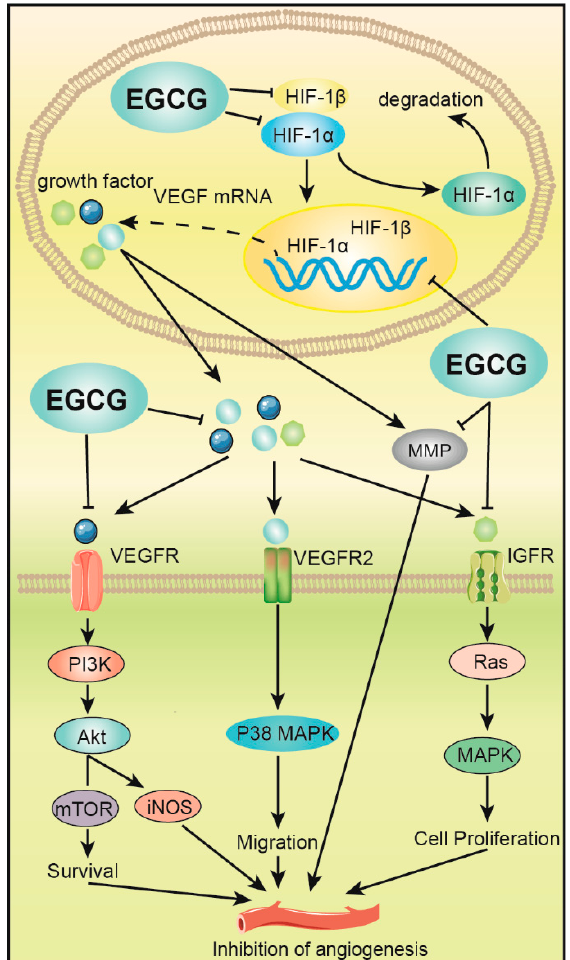
Figure 3. EGCG inhibits angiogenesis of digestive tract tumors. EGCG inhibits the expression of hypoxia-inducible factor (HIF-1 α and HIF-1 β ), which downregulates VEGF expression, and ultimately inhibits the formation and metastasis of tumor vasculature by mediating PI3K/Akt, p38 mitogen-activated protein kinase (MAPK) and MAPK signaling pathways. EGCG also inhibits the activation of enzymes such as matrix metalloproteinase (MMP), thereby inhibiting angiogenesis and growth.